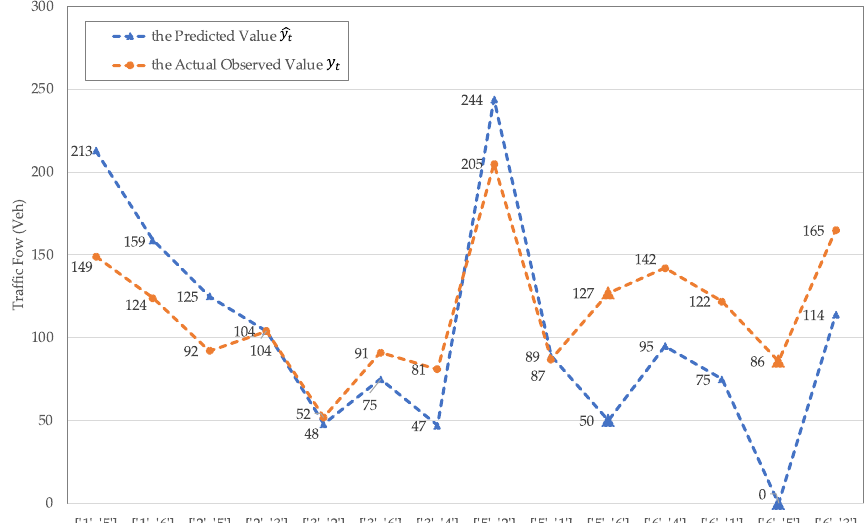
Figure 5. The comparison between the predicted and actual values of traffic flow.